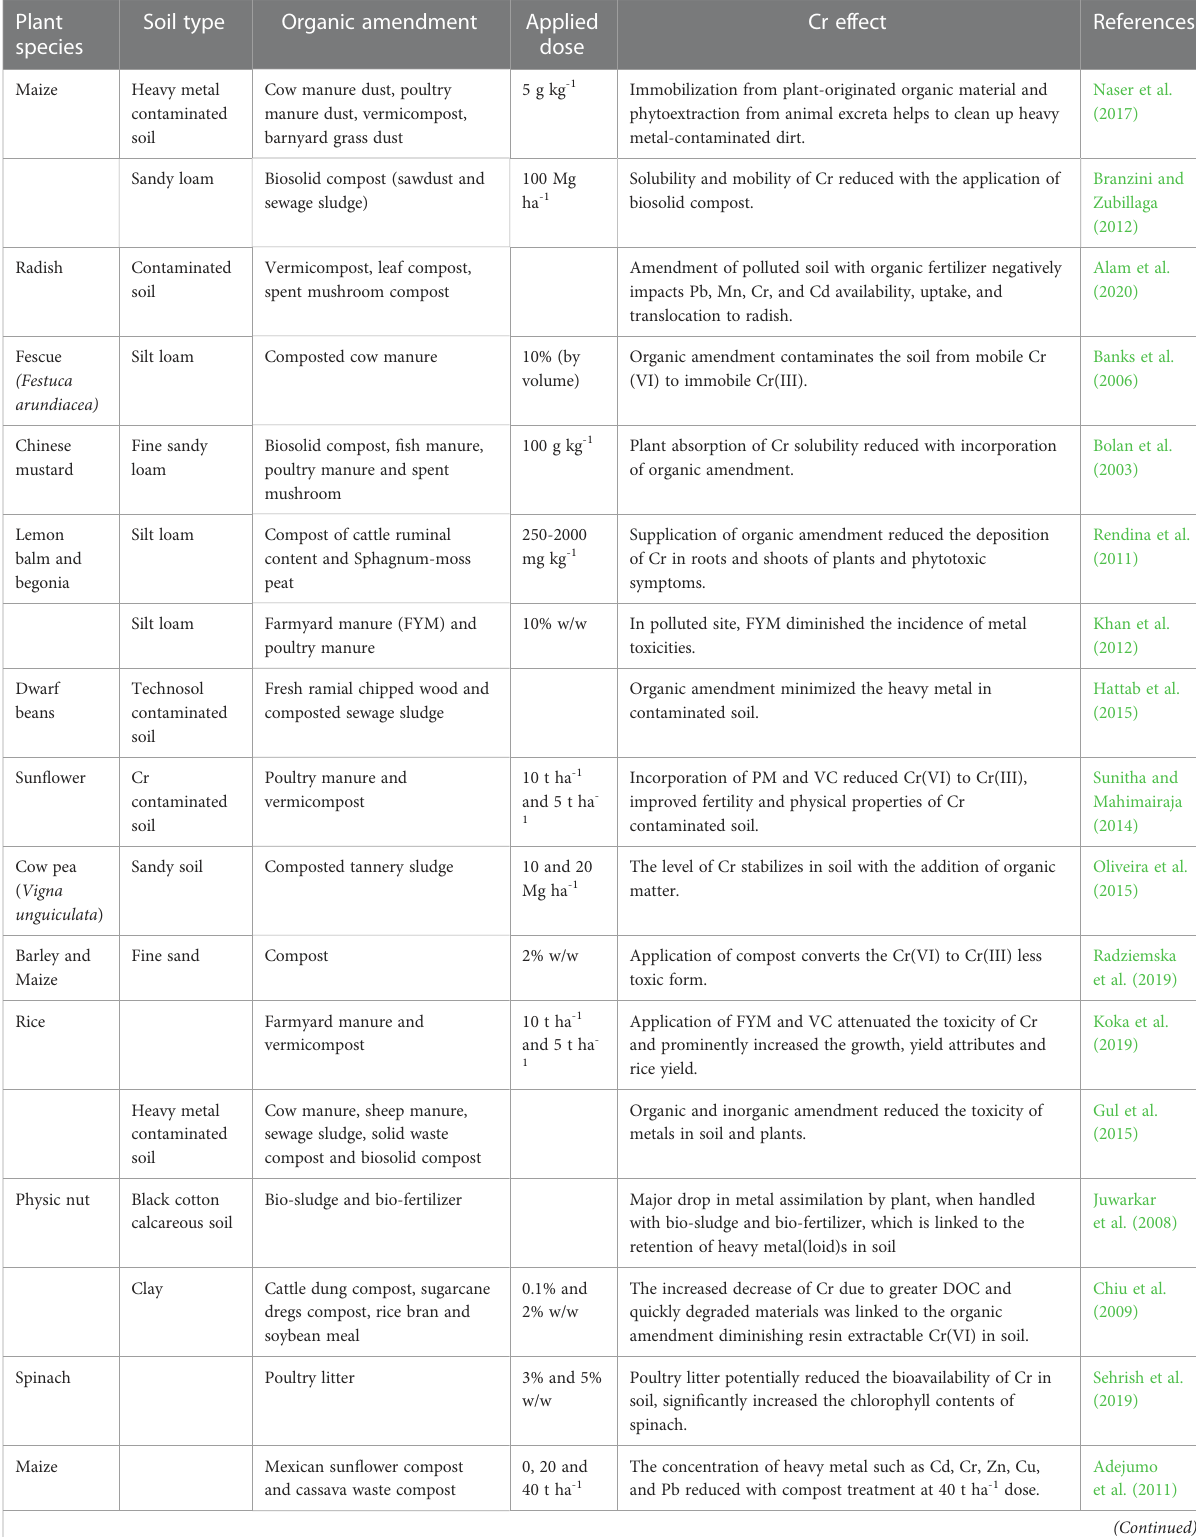
TABLE 8 Effect of organic amendments on remediation of chromium stress in different plant